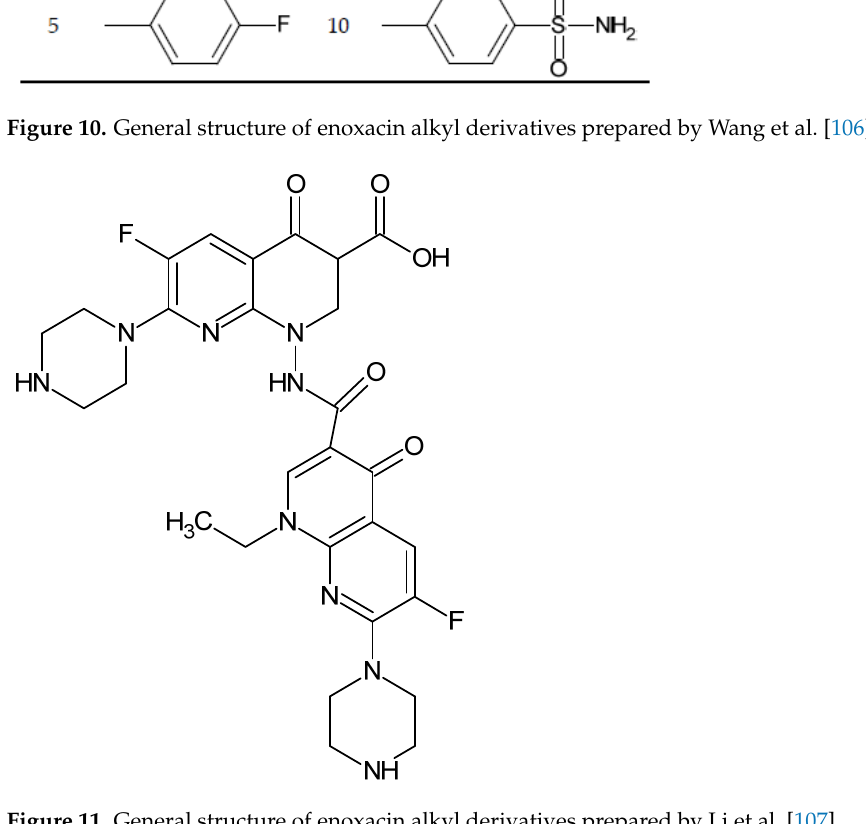
Cancers 2022 , 14 , x FOR PEER REVIEW